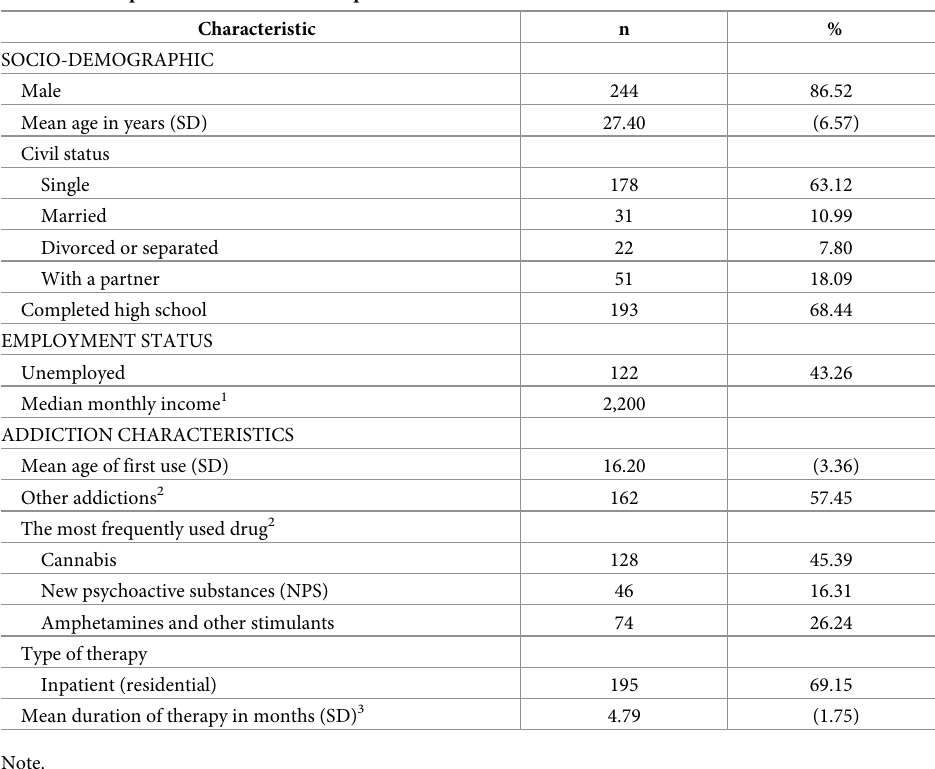
Table 1. Descriptive characteristics of